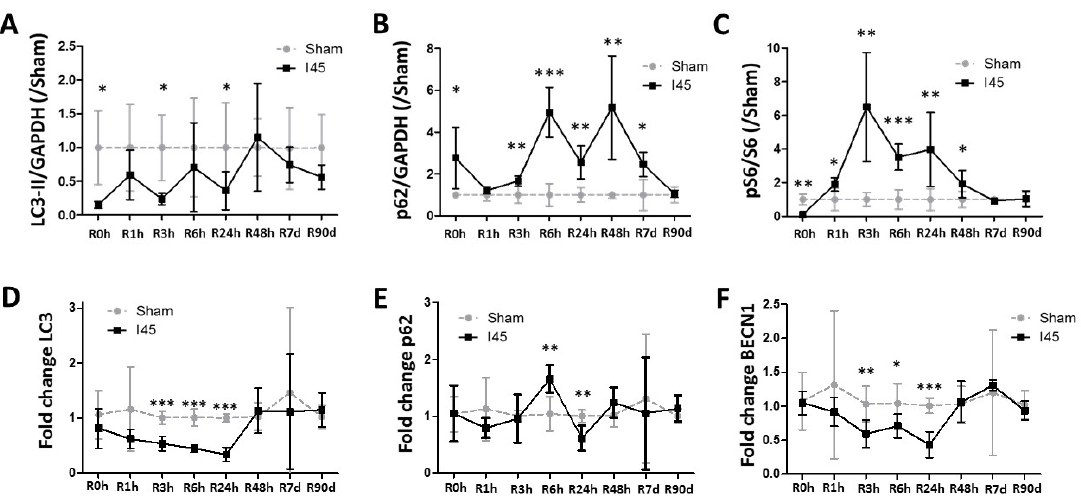
Figure 2. Autophagy is suppressed post reperfusion following mild ischemia. Rats, either Sham-operated (Sham) or subjected to 45 min of renal ischemia (I45), were sacrificed at various time points post reperfusion (R0h, R1h, R3h, R6h, R24h, R48h, R7d, and R90d). Kidney tissue was collected and analyzed by Western blotting for LC3 ( A ), p62 ( B ), S6, and phosphorylated S6 (pS6) ( C ), and by qPCR for the mRNA expression of LC3 ( D ), p62 ( E ), and BECN1 ( F ). * p <0.05, ** p < 0.01, *** p < 0.001. N = 6.